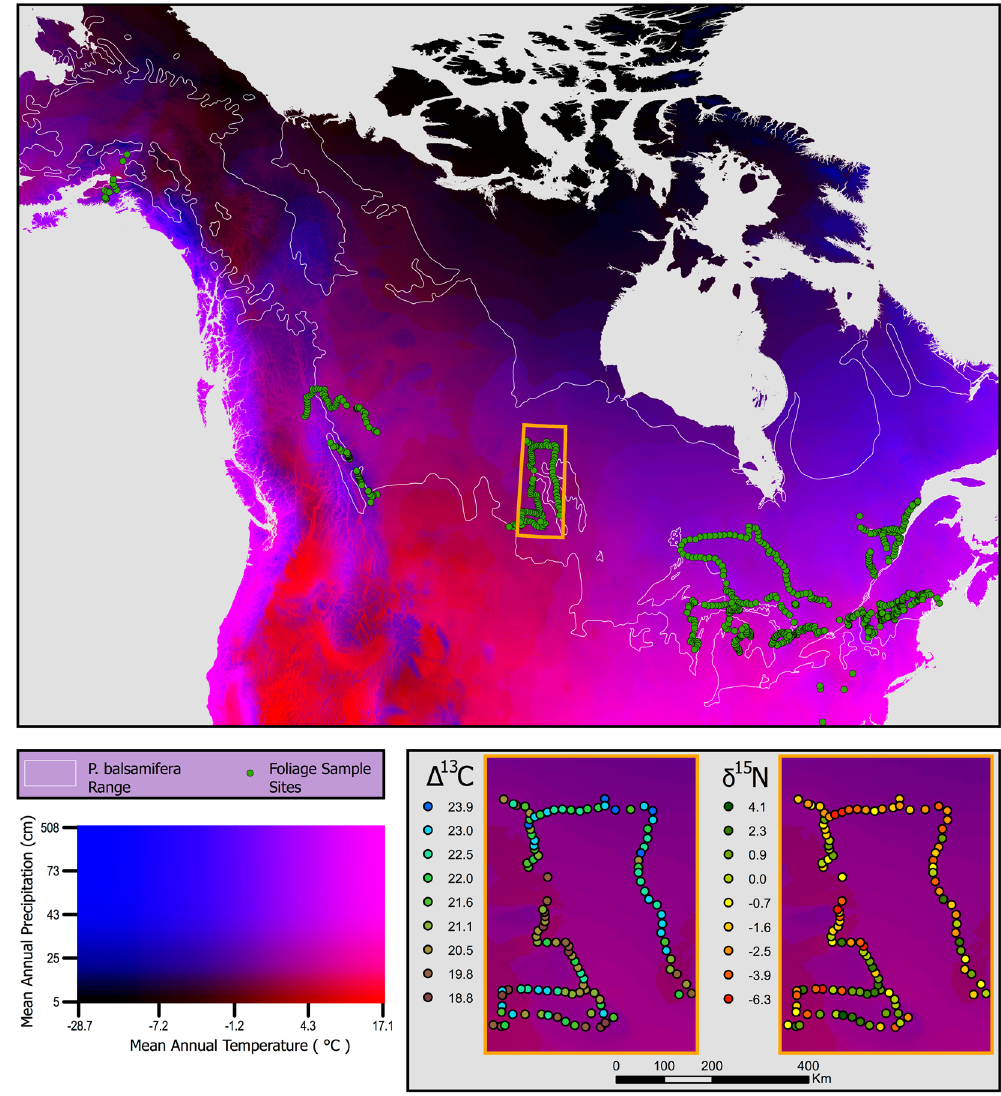
Figure 1. Locations of foliar P. balsamifera samples acquired for this study mapped over mean annual precipitation and mean annual temperature for North America. Inset shows typical fine-grain variability in foliar Δ 13 C and δ 15 N. This map of North America was produced in ArcGIS 10.2.2 (http://www.esri.com/) using Bioclim mean annual temperature and annual precipitation layers 50 . The bivariate legend was produced using custom Python code (https://www.python.org/) developed by